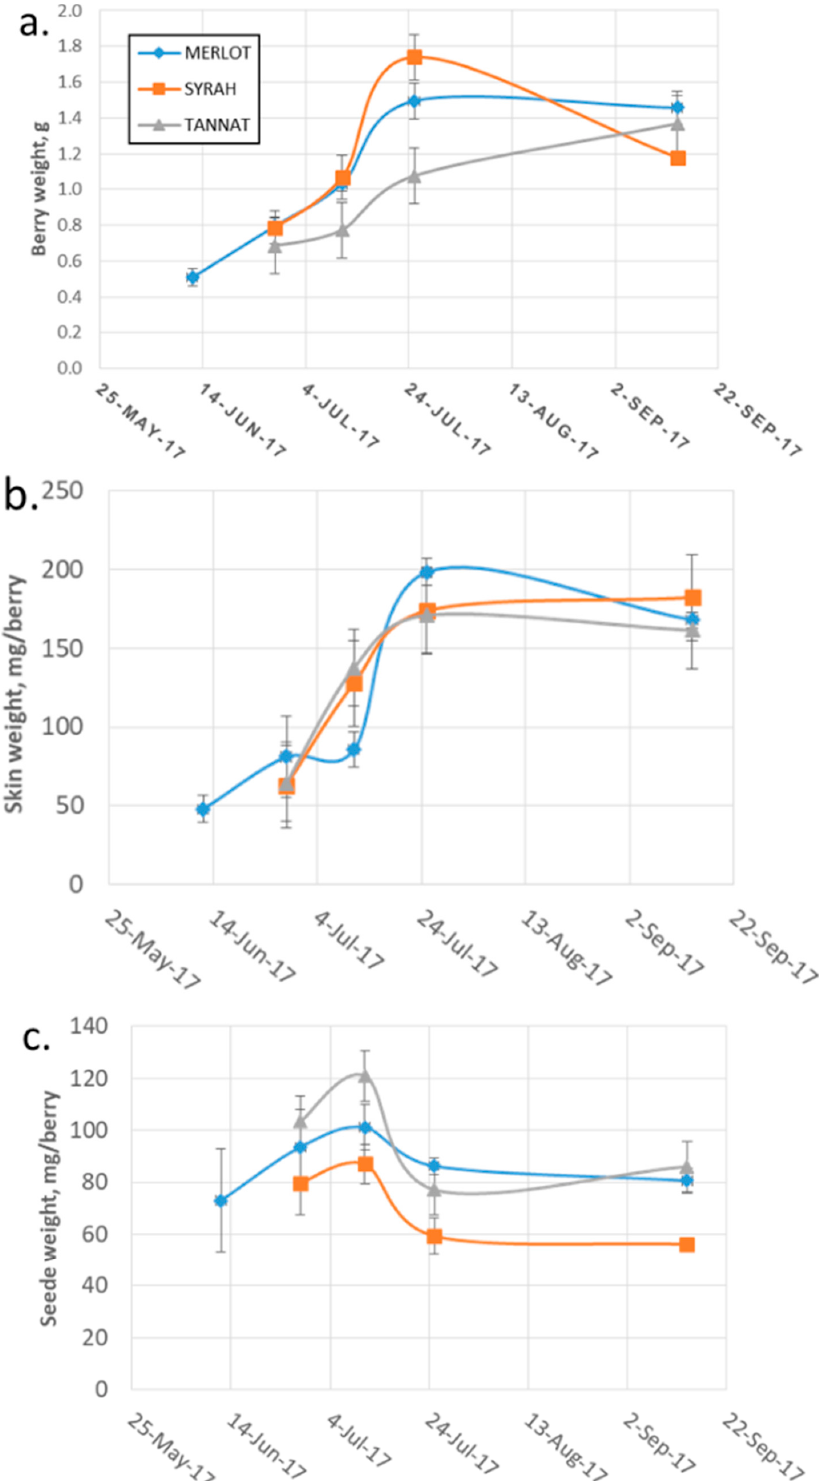
Figure A1. Evolutions of ( a ) berry weight (g), ( b ) skin weight (mg/berry) and ( c ) seed weight (mg/berry) during berry development.